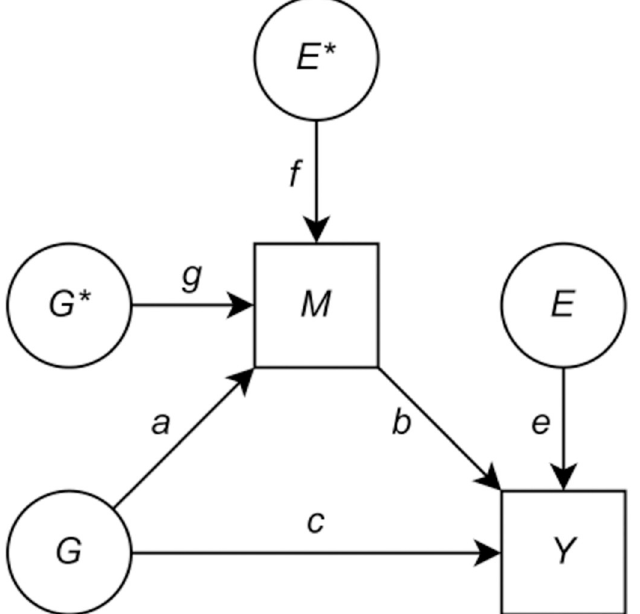
Fig 1. Structural equation model (SEM) for mediation analysis using GREML (MA-GREML), to quantify to which extent the genetic component of trait Y affects trait Y through trait M . G and G � are latent genetic factors, E and E � are latent environmental factors, M is the observed mediator, Y is the observed outcome, ( a 2 + g 2 ) b 2 is the genetic variance of Y that is mediated by M ( indirect effect ), and c 2 is the genetic variance of Y that is not mediated by M ( direct effect ); Full mediation : direct effect = 0 and indirect effect > 0; Partial mediation : direct and indirect effect both > 0; No mediation : direct effect > 0 and indirect effect =